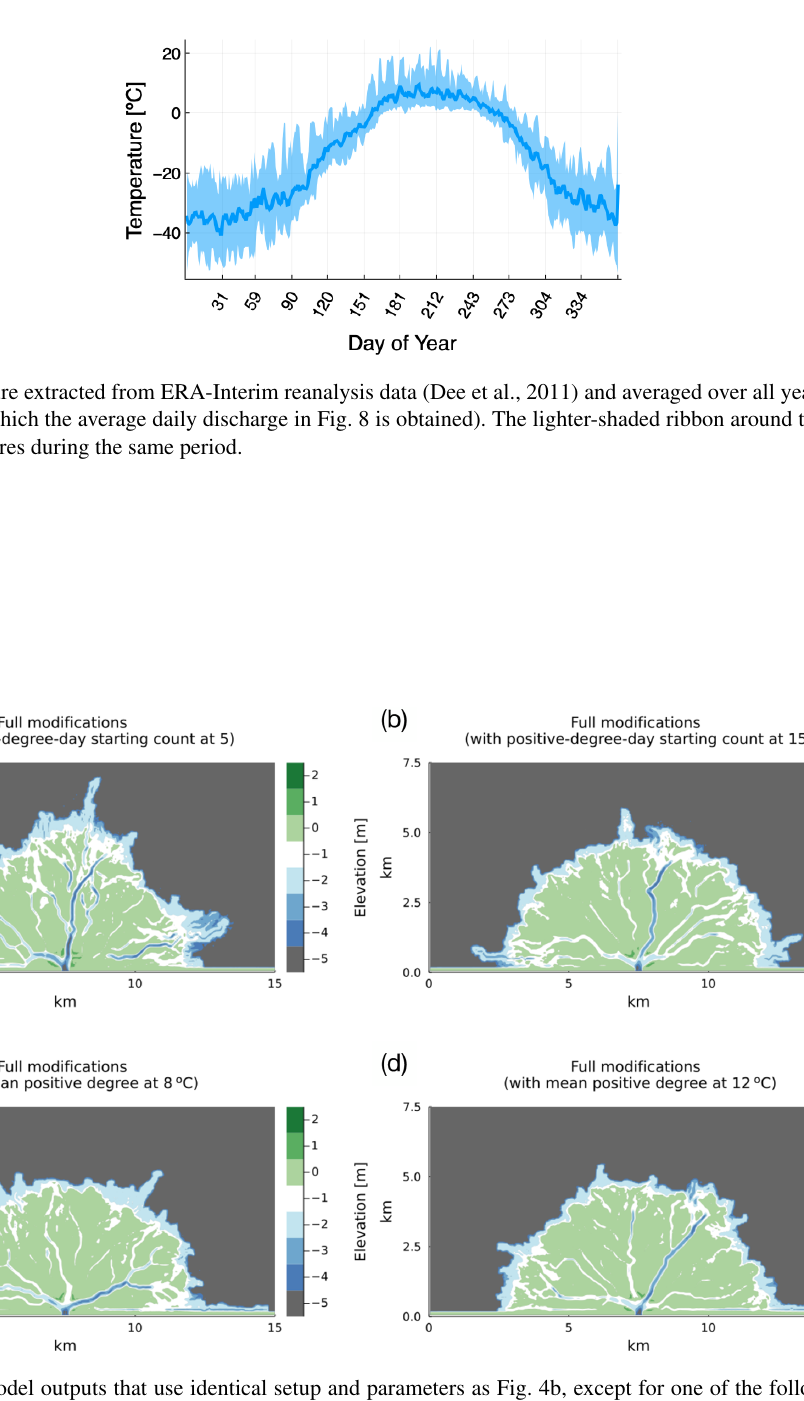
Figure B2. Examples of model outputs that use identical setup and parameters as Fig. 4b, except for one of the following parameters: the positive-degree-day index, I , starts the count at (a) 5d and (b) 15d instead of 10; the average positive temperature used to calculate the positive-degree-day index is (c) 8 ◦ C and (d) 12 ◦ C instead of 4 ◦ C.